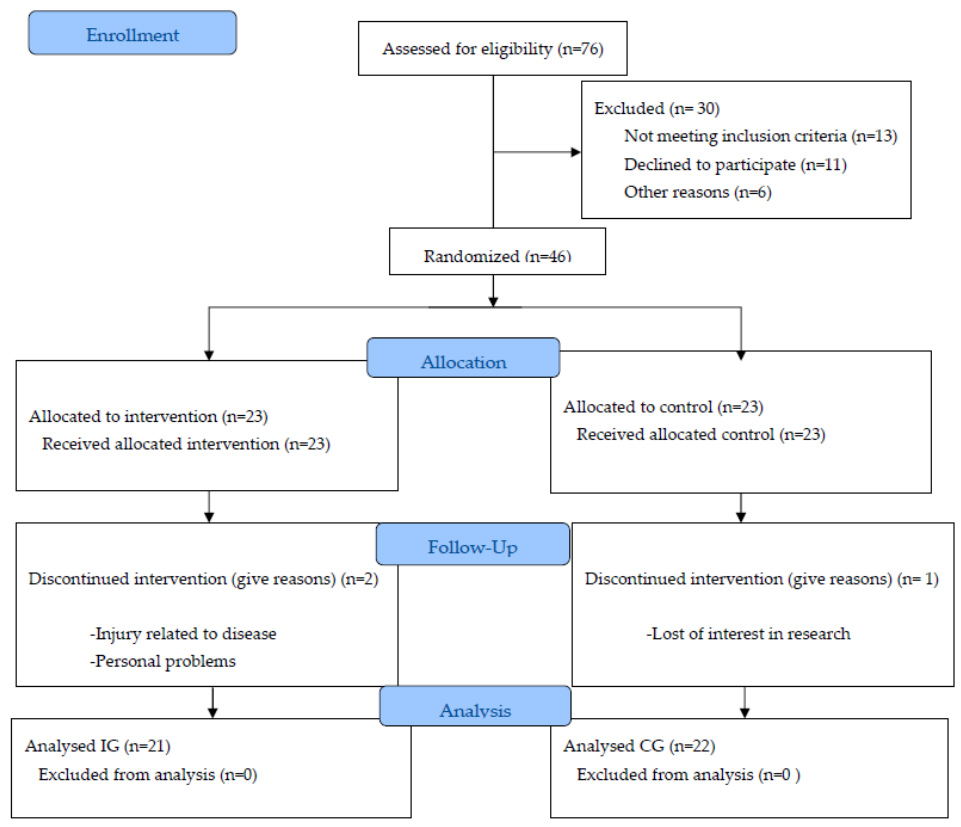
Figure 1. Flow chart. The flow of participants throughout the study protocol. Notes: IC—intervention group; CG—control group; n—number of participants.